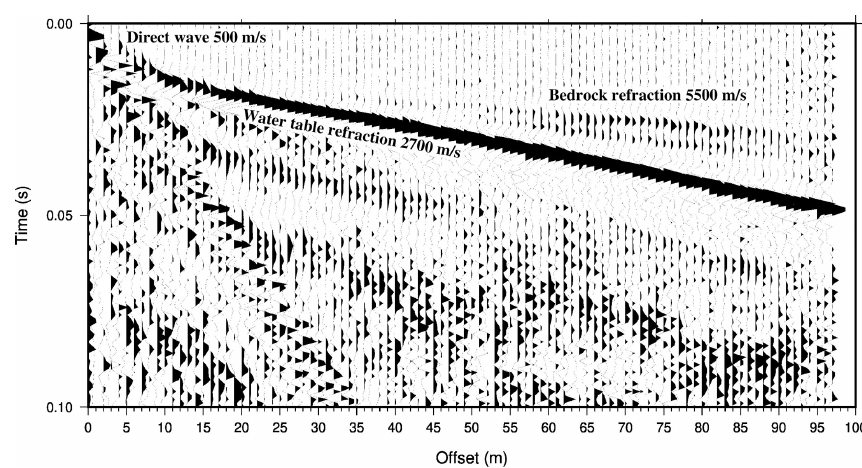
Figure 7. Active seismic test at the site: the direct arrival has a velocity corresponding to dry glacial sediments. The first refractor has a velocity corresponding to water saturated glacial moraine. The weak refraction at offsets greater than about 25m is from the bedrock surface (figure recreated from Juhlin et al.,